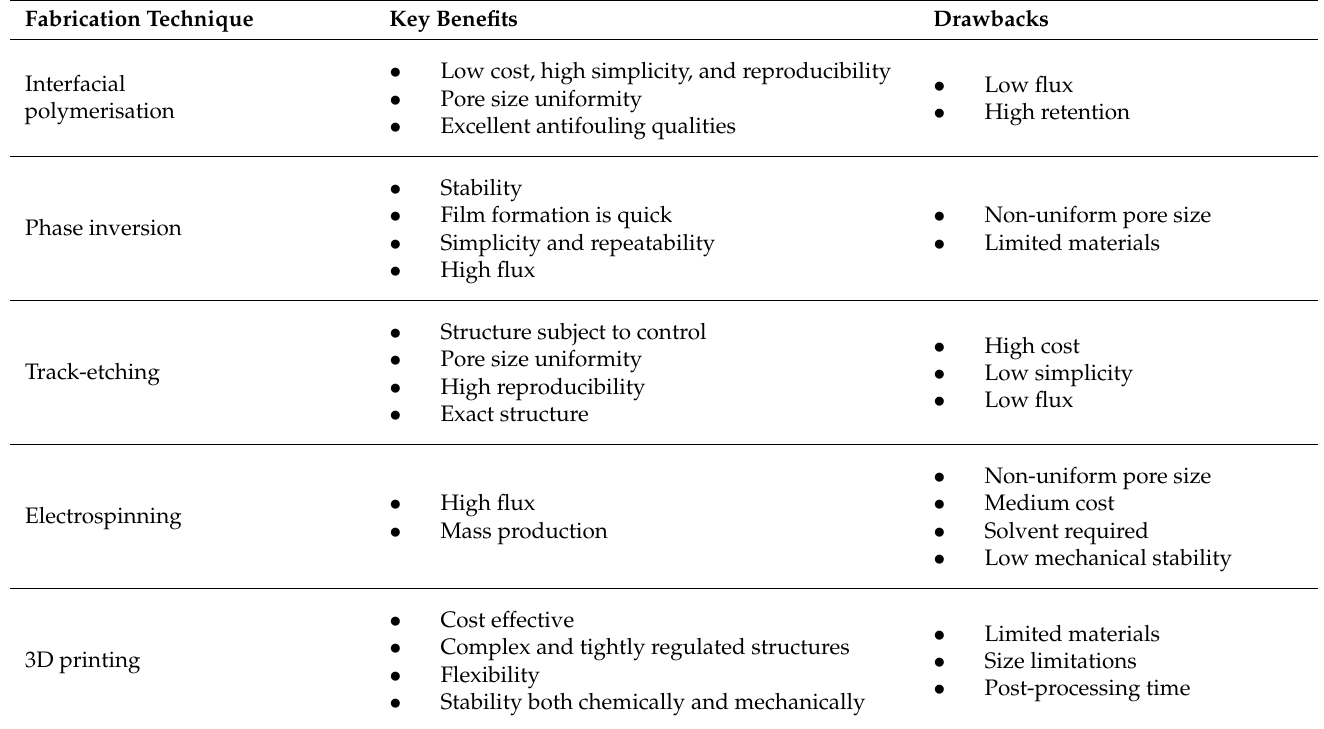
Table 3. Comparison of the key benefits and drawbacks of the various membrane production